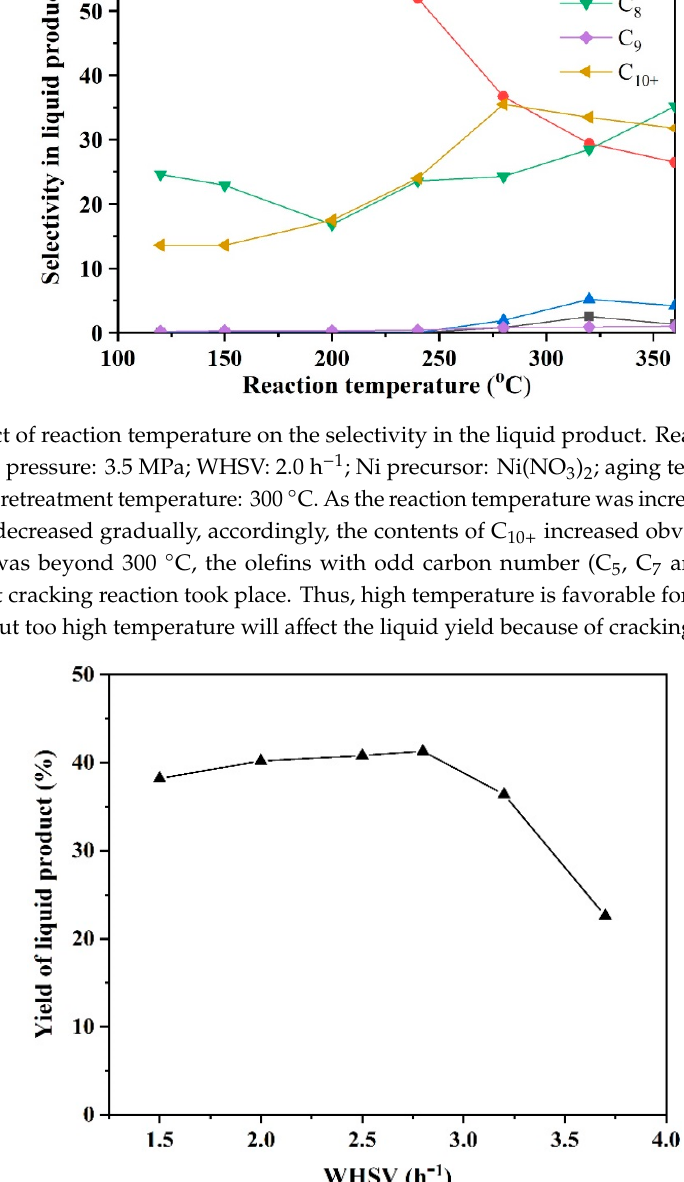
Figure 4. Effect of reaction temperature on the selectivity in the liquid product. Reaction conditions: Si/Al ratio: 25; pressure: 3.5 MPa; WHSV: 2.0 h − 1 ; Ni precursor: Ni(NO 3 ) 2 ; aging temperature: room